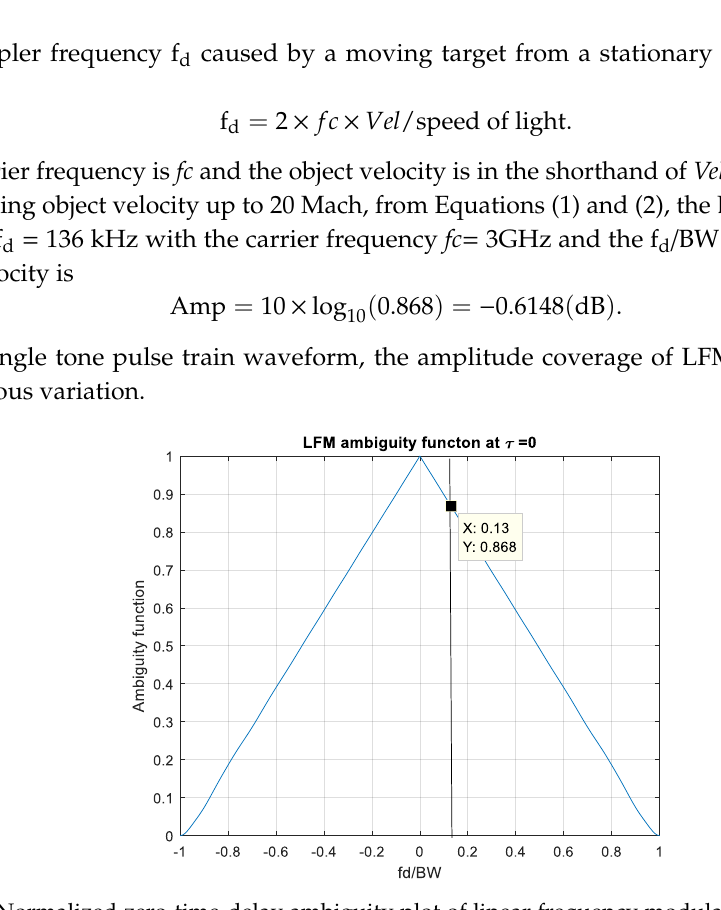
Figure 1. Normalized zero-time-delay ambiguity plot of linear frequency modulation (LFM) pulse. The vertical line marks the Doppler to bandwidth ratio of a moving target at f d /BW = 0.13.